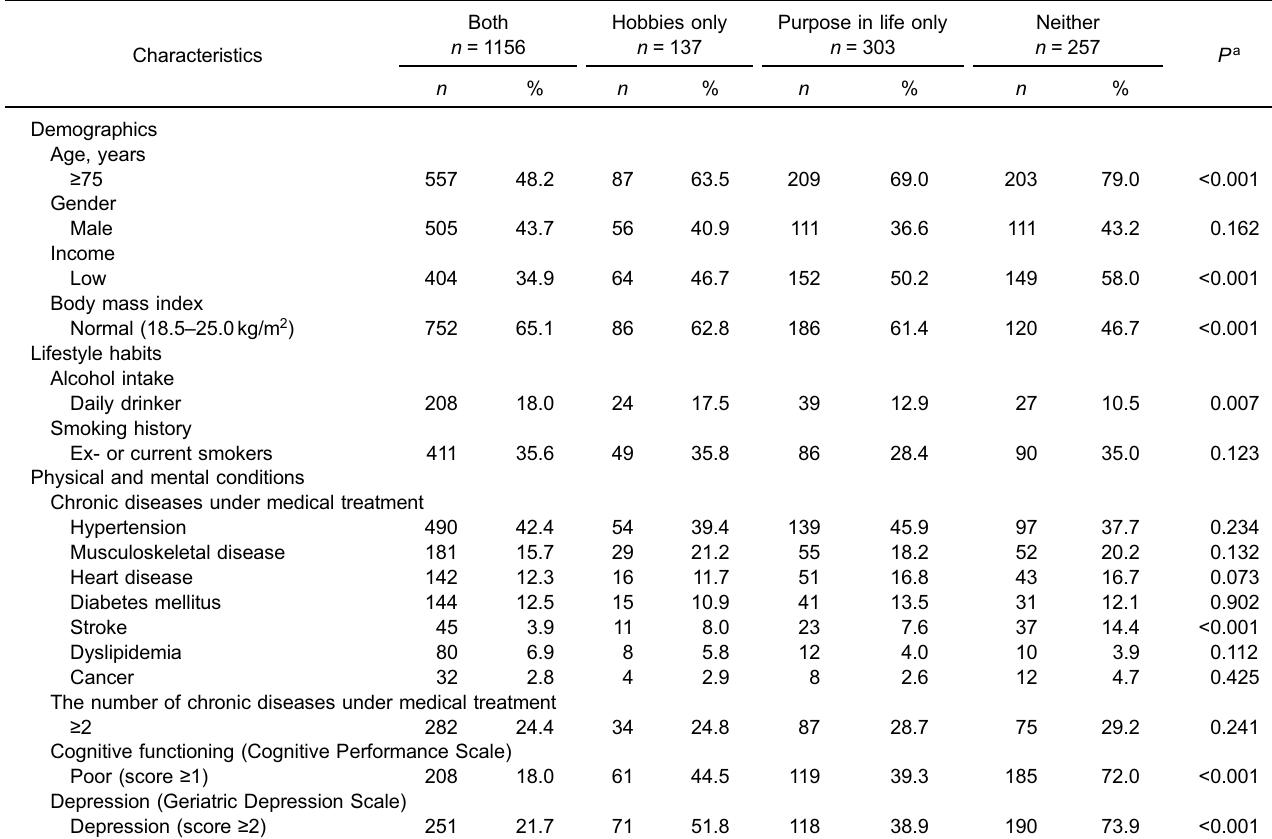
Table 1. Baseline characteristics of study participants according to hobbies and a purpose in life ( ikigai )